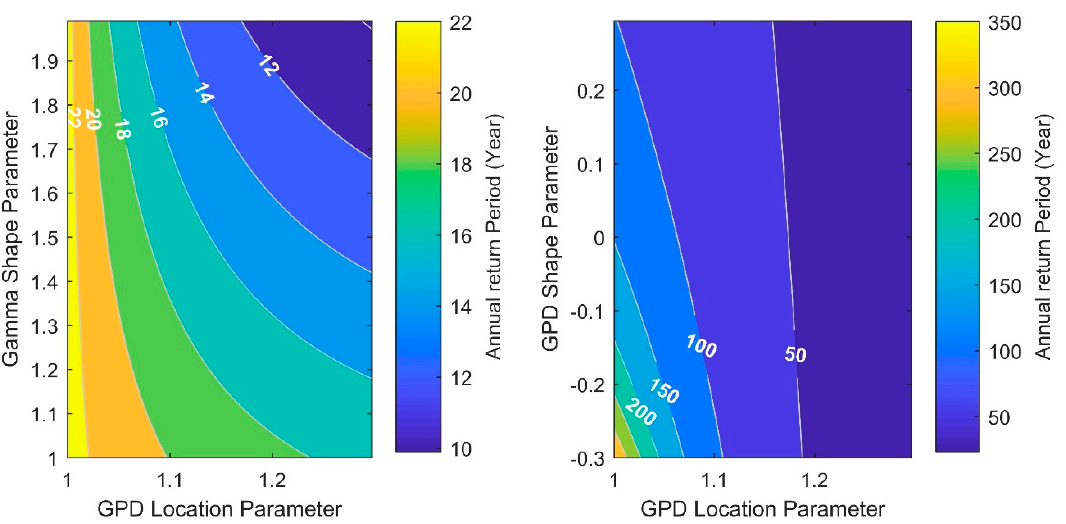
Figure 3. Sensitivity of drought return period to Gamma shape parameter and GPD location parameter below the threshold ( left-panel ) and GPD shape and GPD location parameters over the threshold ( right-panel ).